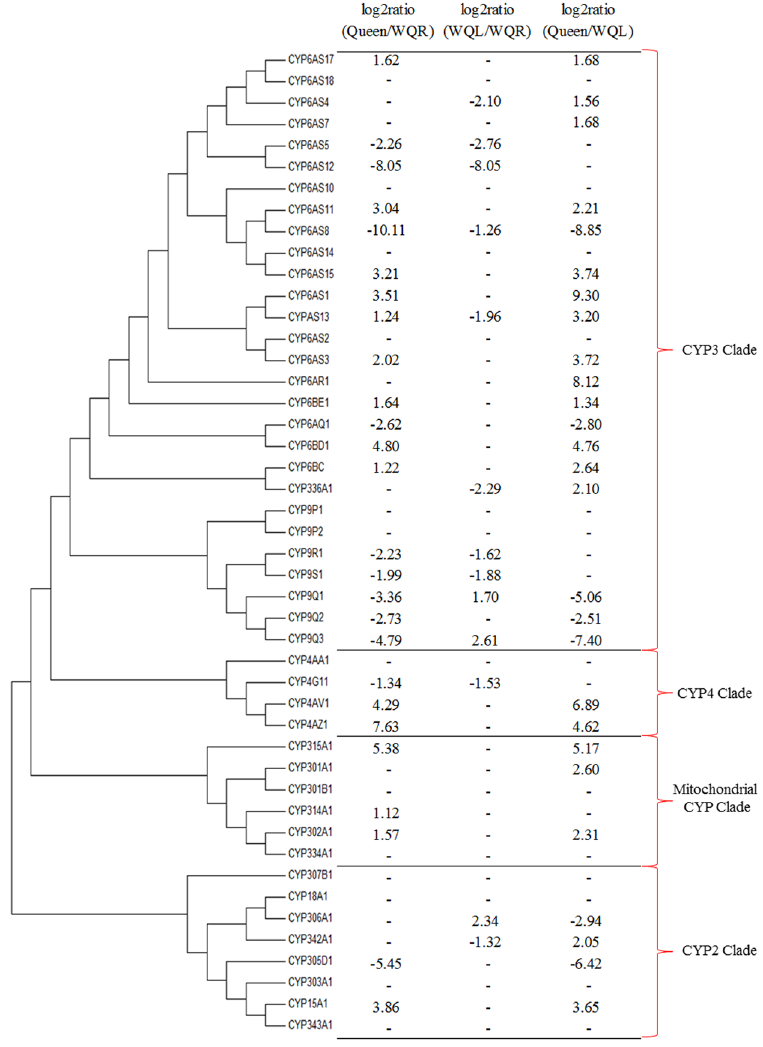
Figure 3. Neighbor-joining phylogeny for the honey bee P450 sequences and the expression pattern of P450 genes. RPKM was used to calculate the log2ratio (A/B). The positive number means that this gene was highly expressed in the latter group (B) and the negative number means this gene was highly expressed in the former group (A). “–” means that the log2ratio does not fit the statistical criteria (|log2Ratio| ≥ 1 and FDR ≤ 0.001) and that the gene was not differentially